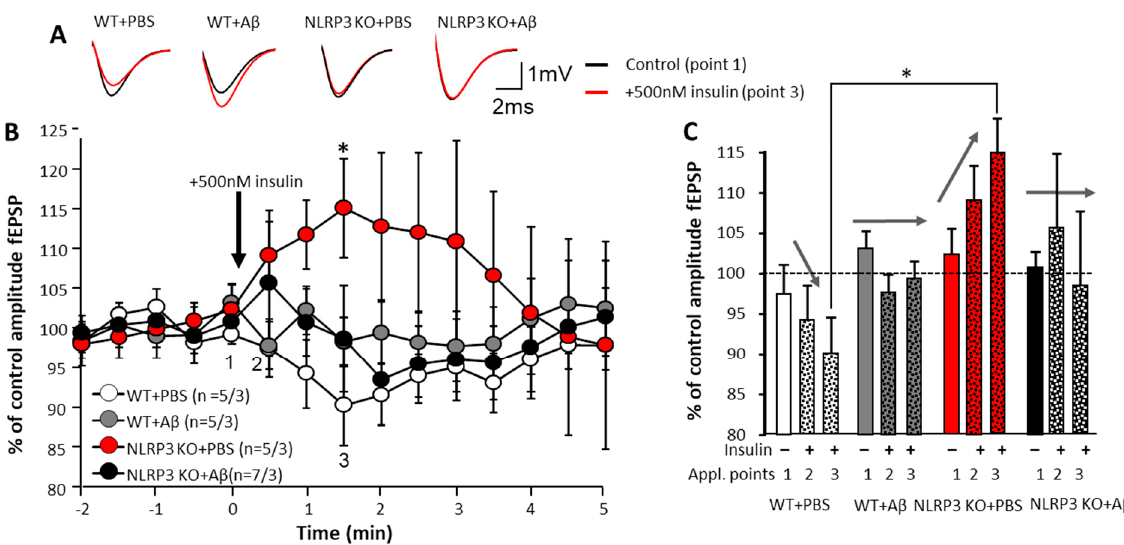
Figure 4. Effect of insulin application on synaptic transmission in the brain amygdala. ( A ) Upper panel shows representative traces of fEPSPs before (black) and after (red lines) 500 nM insulin application. ( B ) Lower panels show dynamics of pooled data for the fEPSPs amplitudes (control points 2 at 0.5 min and 3 at 1.5 min) normalized to the baseline period before insulin application (point 1 at time 0 min). The groups are marked with corresponding colors. ( C ) The summary graphs show the normalized average fEPSP amplitudes at points 1, 2 and 3 (See Figure 5B). Arrows shows the direction of fEPSPs amplitude dynamics in response to insulin application. WT—wild type control mice, NLRP3 KO—NLRP3 knockout mice, A β —amyloid beta injection, PBS—phosphate buffered saline injection (sham operation). * p < 0.05.